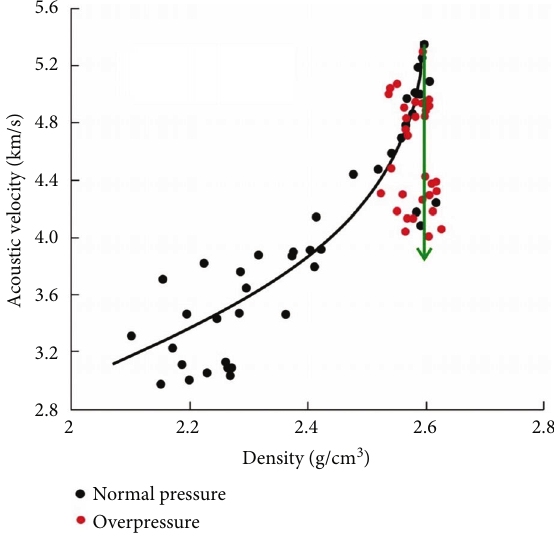
Figure 13: Sonic velocity-density intersection diagram of mudstone in well